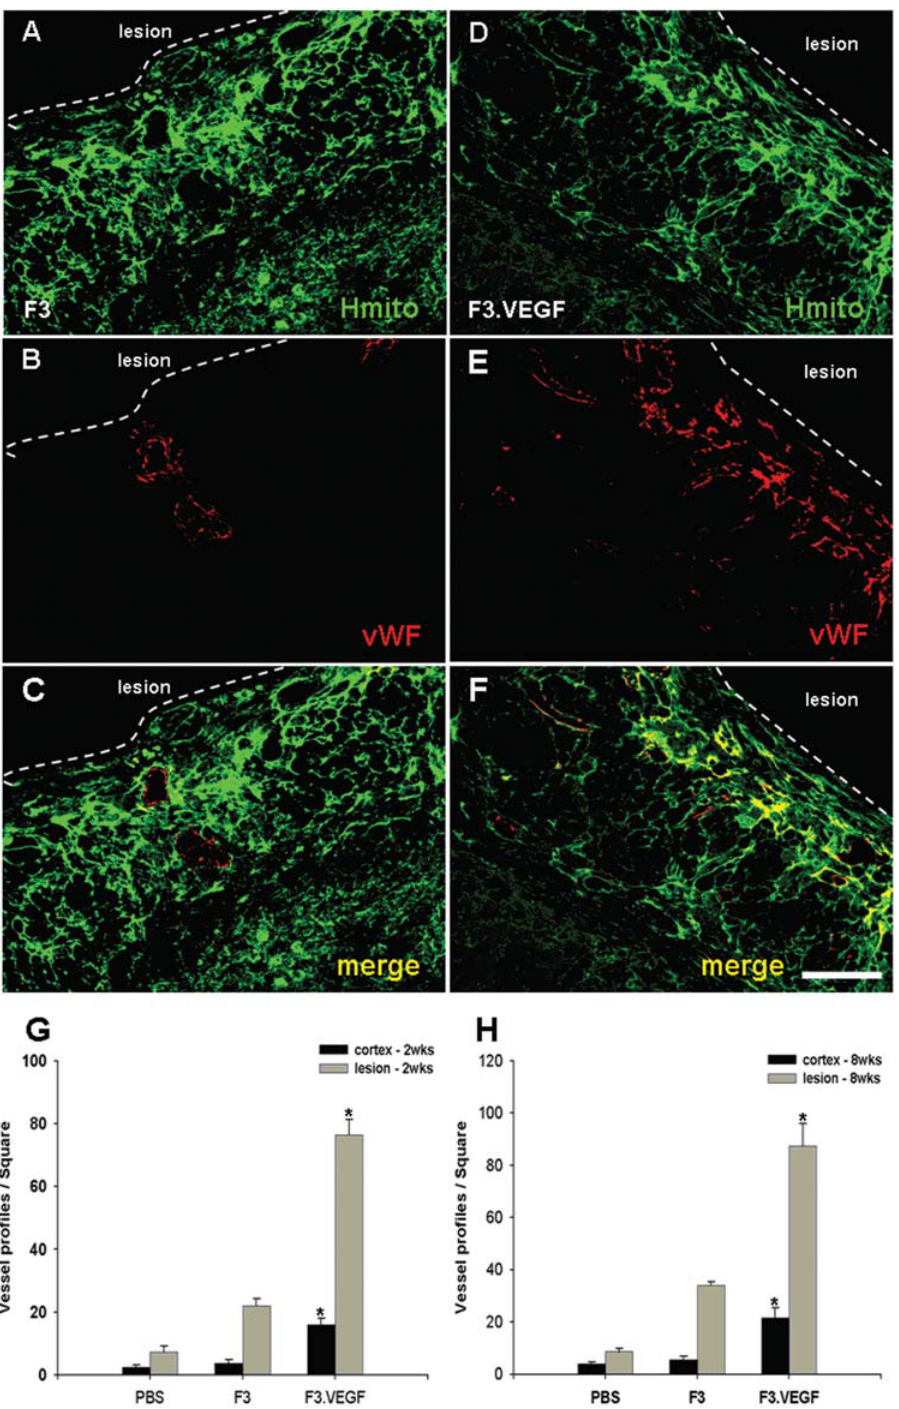
Figure 7. A promoted angiogenesis in hemorrhage lesion by transplanted F3 (A–C) and F3.VEGF (D–F) human NSCs was demonstrated by double immunofluorescence staining of human motochondria (HuMit, green) and von Willebrandt factor (vWF, red). Number of microvessels immunoreaction-positive for von Willebrandt factor is significantly increased in F3.VEGF group as compared with control F3 group. Bar indicates 50 m m. * P , 0.001 doi:10.1371/journal.pone.0000156.g007 (Fig. 8A–D). The number of TUNEL-positive cells in ICH/ PBS-ICH control animals. At 8 weeks post- transplantation in the F3.VEGF brain was similar in the lateral or medial borders. This hemorrhage core border areas, the number of TUNEL-positive pattern was similar in ICH mice grafted with F3 cells. Interest- cells was much lower in the ICH animals receiving transplantation ingly, the number of TUNEL-positive cells bearing nuclear DNA of F3.VEGF cells than ICH animals receiving PBS or F3 cells